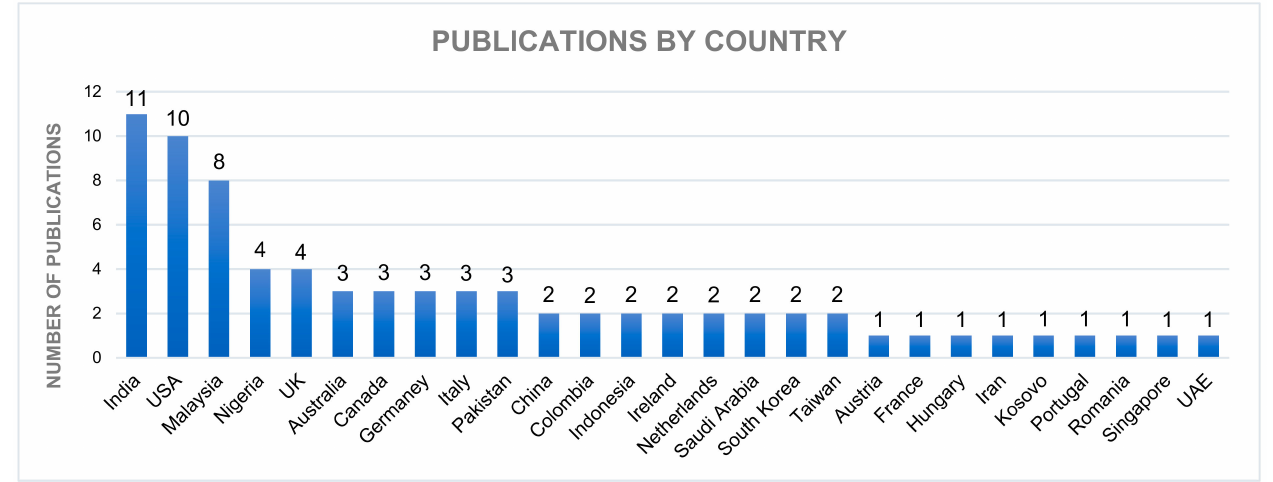
Figure 4. Distribution of articles published by country.